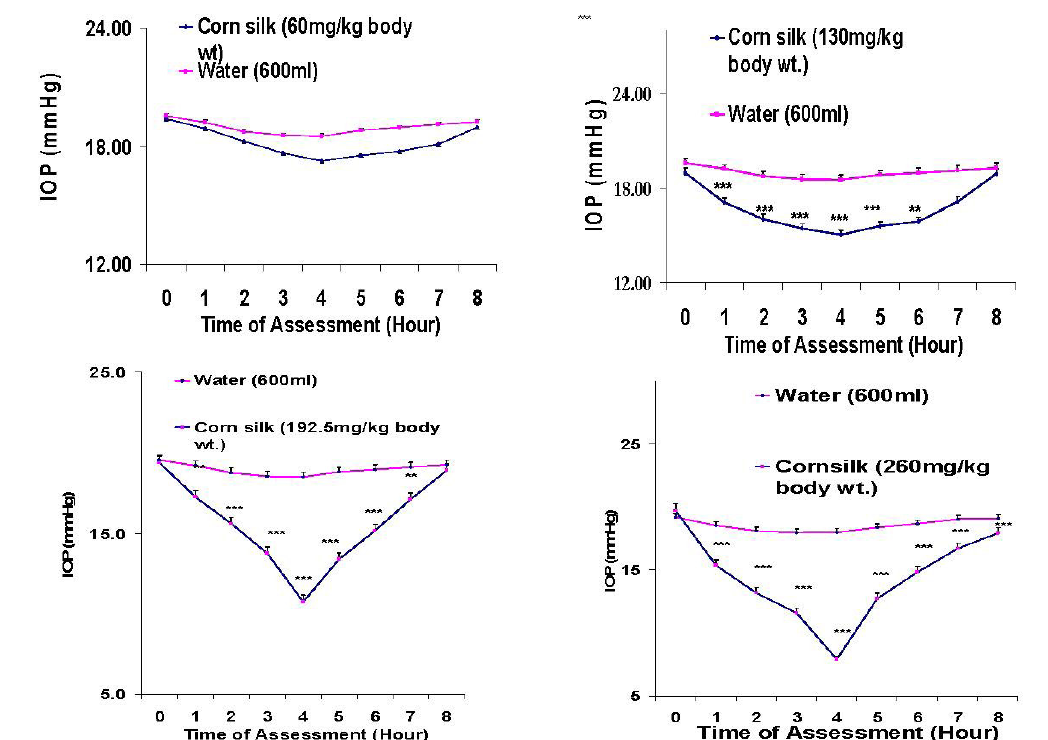
Figure 2 : The mean difference in IOP was significant (p<0.001) after administering 130 mg/kg, 192.5 mg/kg and 260 mg/kg body wt. of CSAE, across different time of assessment in right eye of normotensives. Maximum fall in mean IOP was after four hours. (* p < 0.05; ** p < 0.01; *** p <